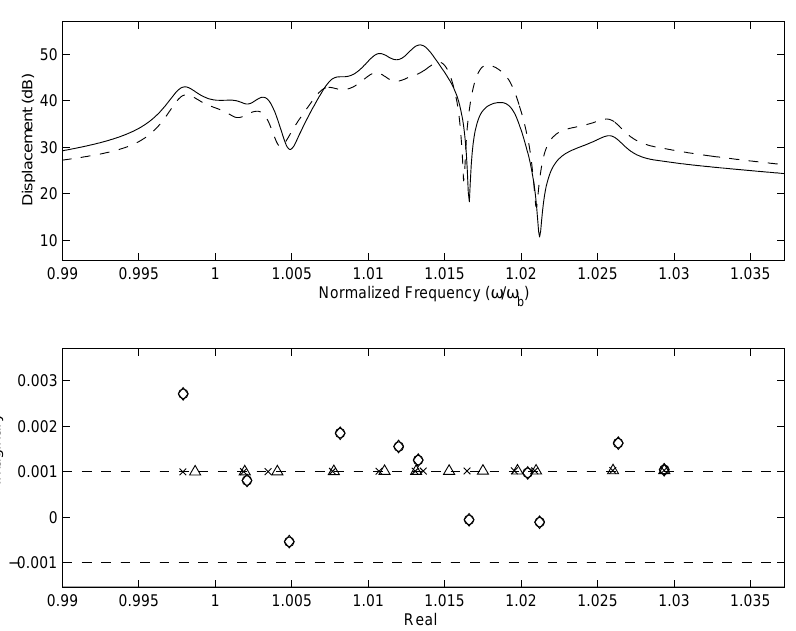
Fig. 9. Blade FRF Sensitivity to Self Mistuning (E=3). a) Blade FRF. — Before, - - - After. b) Pole/Zero Map. ( × , ◦ ) - (pole, zero) before, ( (cid:2) , ♦ ) - (pole, zero) after. Zeros between the dashed lines reduce the response more than the poles amplify